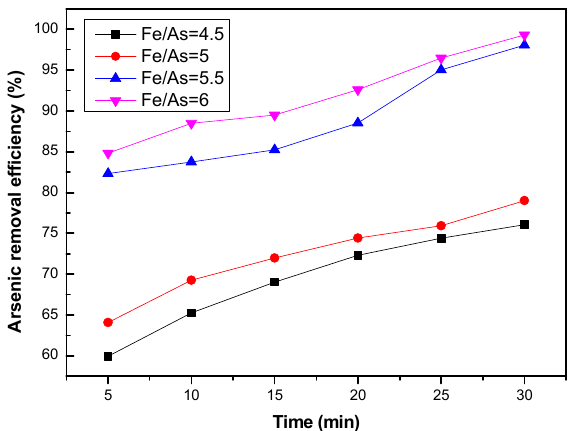
Figure 3. Effect of the molar ratio of iron to arsenic on arsenic removal efficiency (experimental conditions: CuSO 4 concentration was 0.5 g/L, reaction time was 30 min, reaction temperature was 20 °C, and stirring speed was 300 rpm).